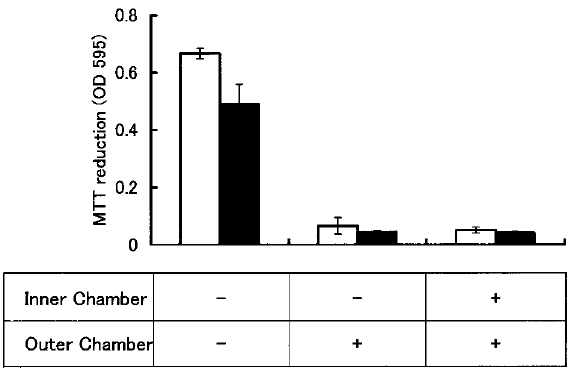
FIG. 2. Test of the requirement for direct contact between rhMRP8/rhMRP14 and EL-4 cells to exert a cytotoxic effect. Divalent-cation-depleted medium without or with rhMRP8/ rhMRP14 complex was added to the inner and outer chambers of a double-chamber culture system, in which the two chambers were separated by dialysis membrane (3500 cut-off) as described in Materials and methods. After being stored at 4°C for 3 days, EL-4 cells were added to the inner and outer chambers as indicated. After culturing for 48h, MTT-reducing activity of EL-4 cells in the inner chamber (white bars) and the outer chamber (black bars) were measured. Bars represent standard deviations of triplicate estimations.